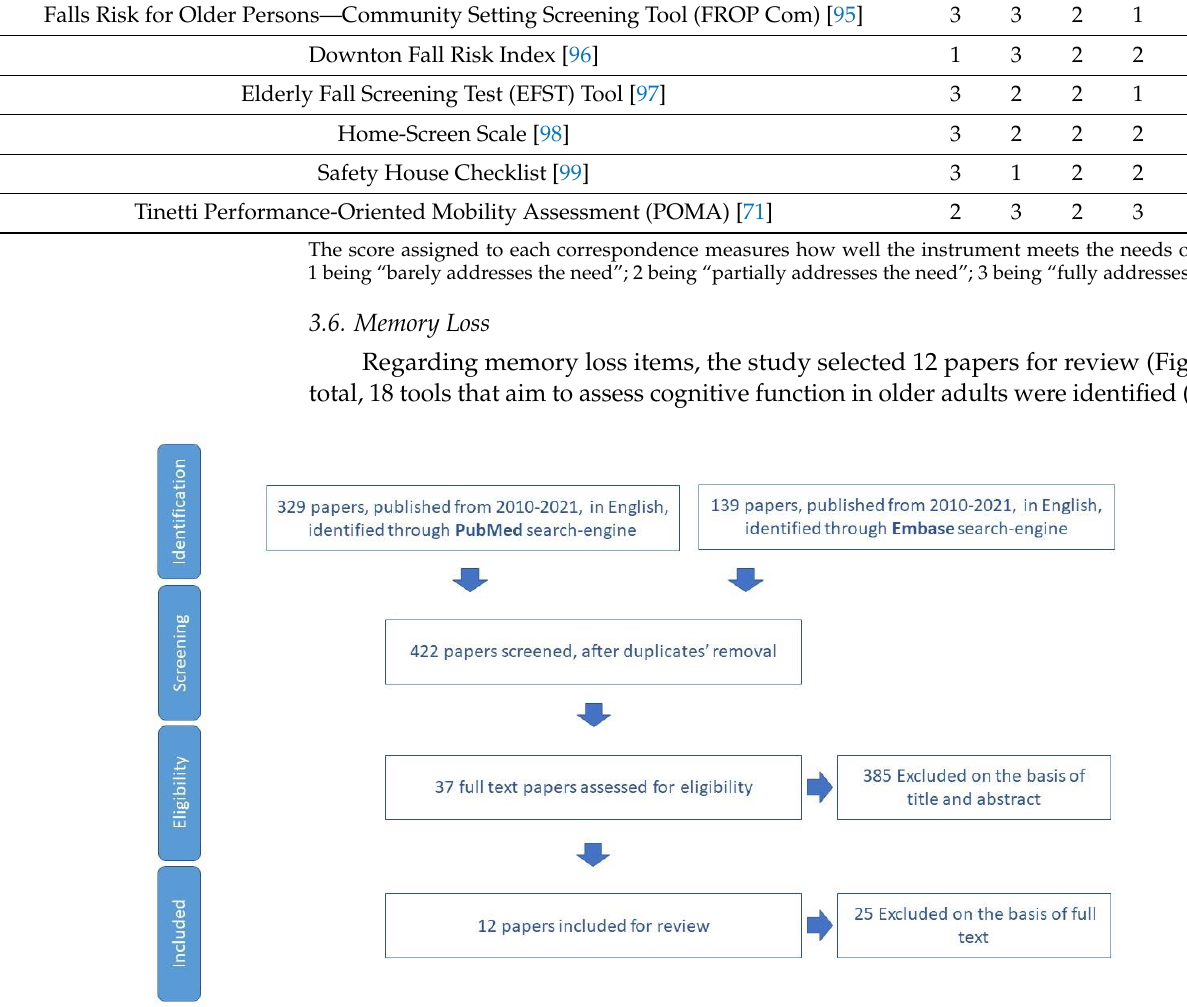
Figure 7. Process of study selection for the assessment of cognitive decline.